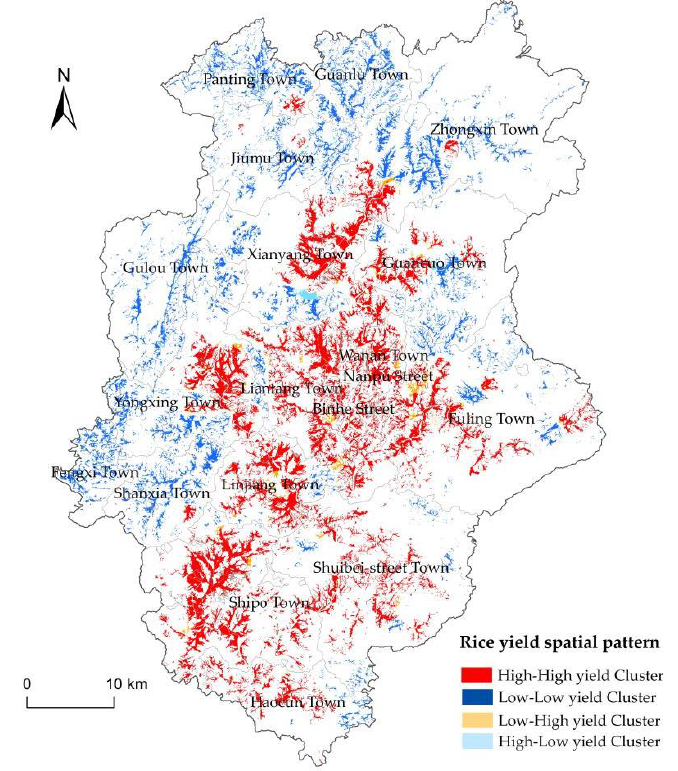
Figure 5. Spatial pattern of rice yield in Pucheng County.